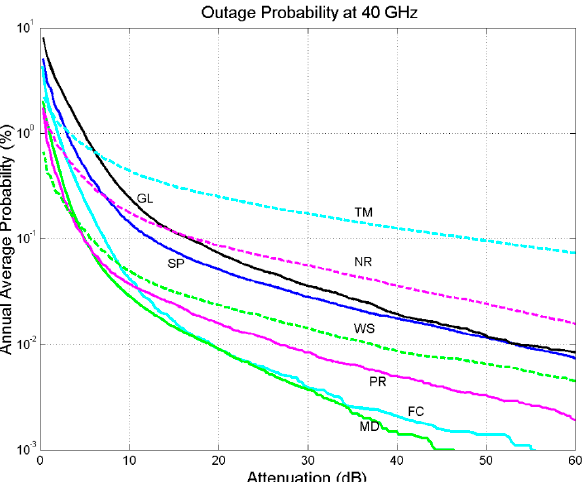
Figure 2. Annual average probability P ( A ) (%) of exceeding the rain attenuation A (dB) indicated in abscissa, at the indicated sites: Spino d’Adda (SP, blue continuous line); Gera Lario (GL, black continuous line); Fucino (FC, cyan continuous line); Madrid (MD, green continuous line); Prague (PR, magenta continuous line); Tampa (TM, cyan dashed line); Norman (NR, magenta dashed line); White Sands (WS, green dashed line), at 30 GHz in zenith paths. When the power margin in the zenith radio-links of the GeoSurf satellite constellations is equal to A (dB), P ( A ) represents the outage probability.